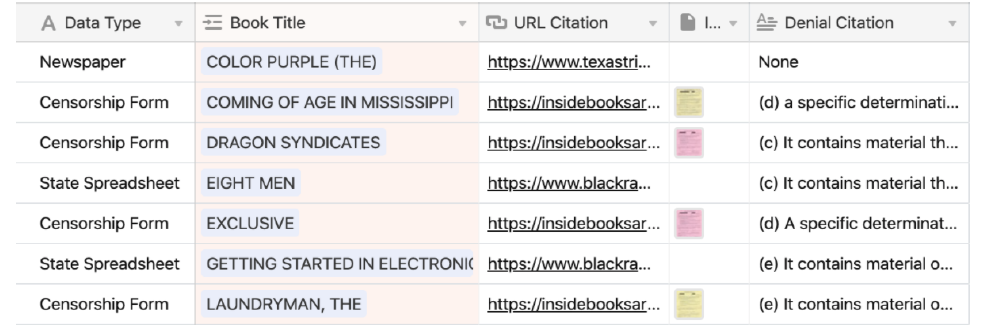
Figure 3. The citation page of the database provides metadata on each book denial. This may include a URL link to the reported ban, a signed denial form from a prison, or a link to a statewide list of